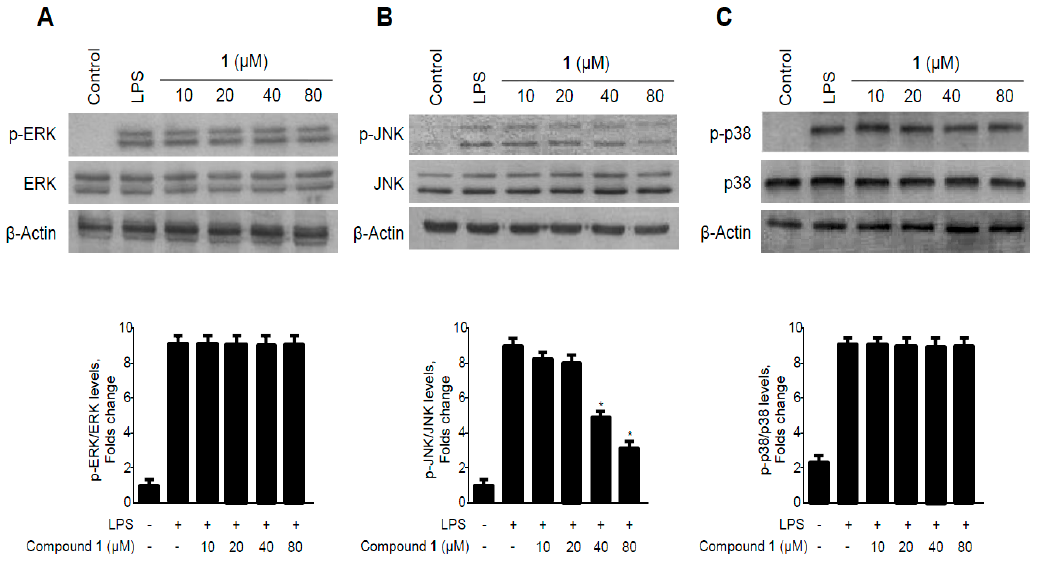
Figure 10. Effects of methylpenicinoline ( 1 ) on ERK, JNK, and p38 MAPK phosphorylation and protein expression in BV2 microglia. Cells were pre-treated for 30 min with the indicated concentrations of 1 and stimulated for 30 min with LPS (500 ng/mL) ( A – C ). The levels of (A) phosphorylated-ERK (p-ERK); (B) phosphorylated-JNK (p-JNK); and (C) phosphorylated-p38 MAPK (p-p38 MAPK) were determined by western blotting. Representative blots from three independent experiments are shown. Data represent the mean values of three experiments ± S.D. * p < 0.05 compared to the group treated with LPS